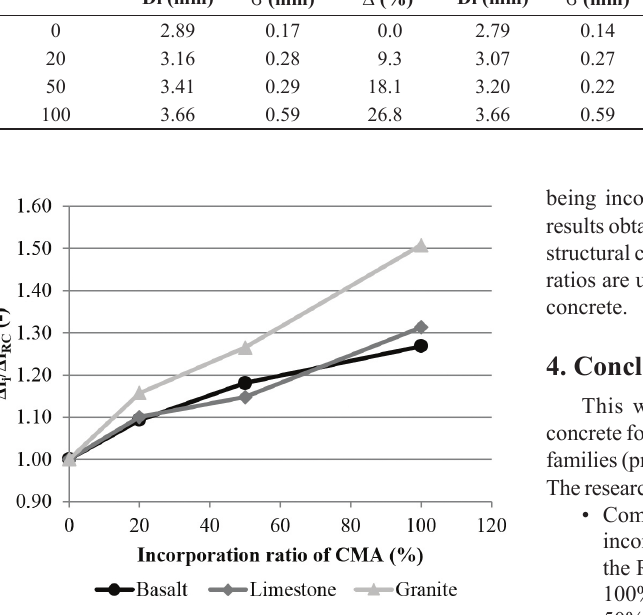
Figure 11. Abrasion wear loss relative to the RC.